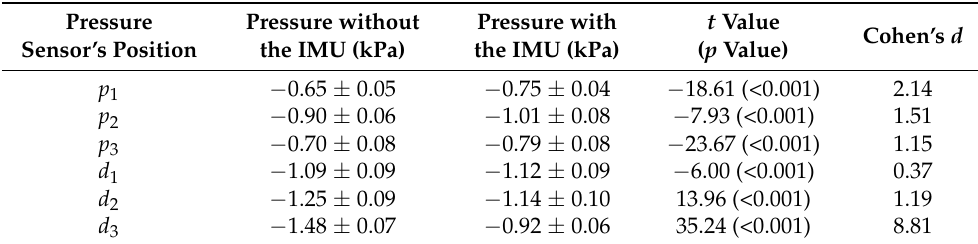
Table 2. Comparison of pressure on hand model between cases with and without the IMU based on 0° and 1.6 m·s − 1 .